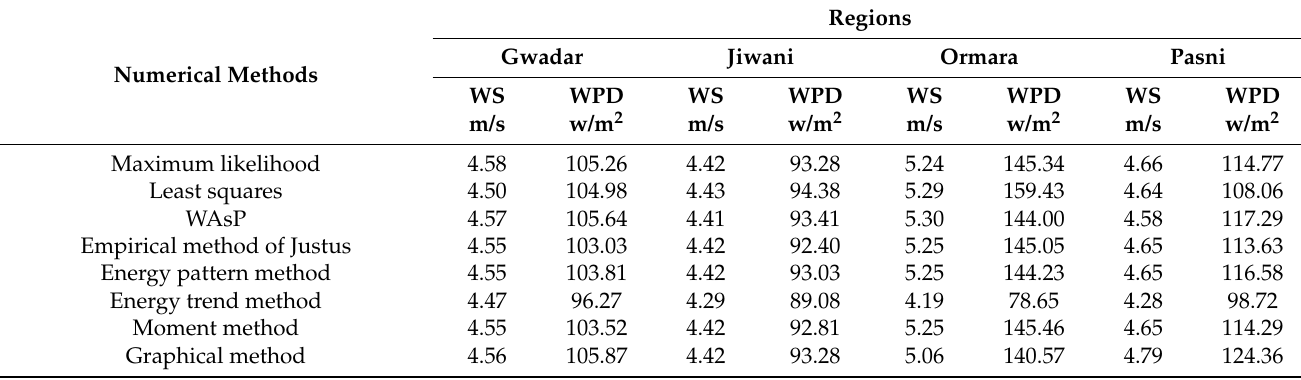
Table 10. Average WS and WPD for eight numerical